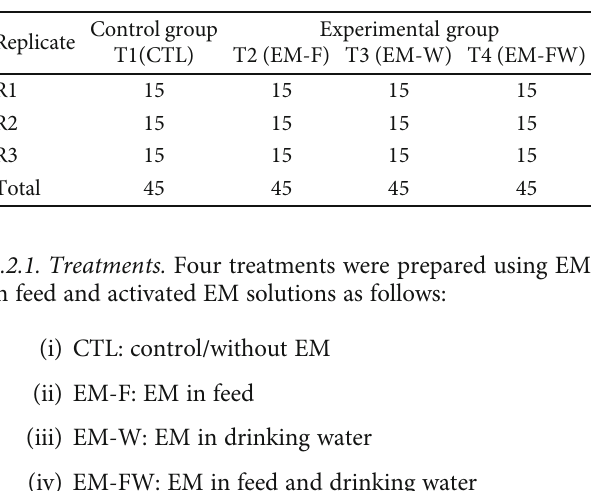
Table 1: Experimental cages and experimental